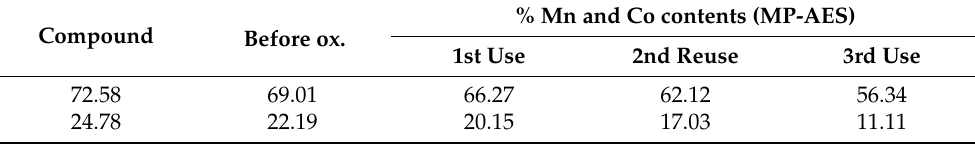
Table 3. MP-AES analysis of Mn and Co contents in compounds 1 and 2 before and after recyclabil- ity tests.